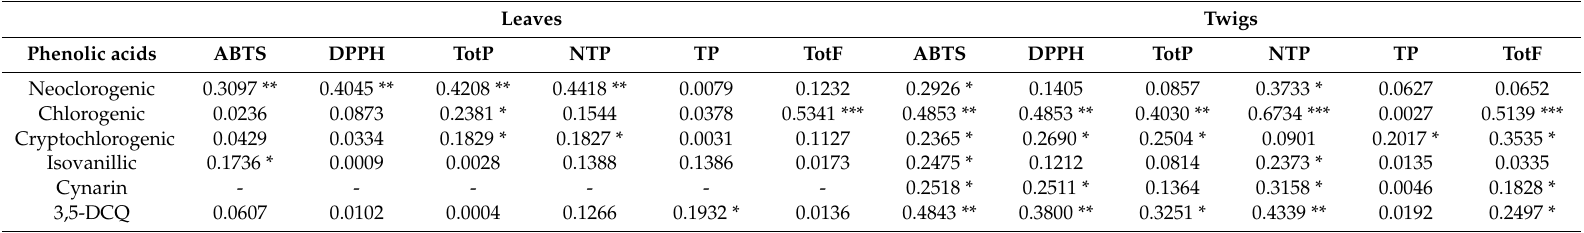
Table 6. Correlations (R 2 ) established between antioxidant capacity (ABTS, DPPH), total phenolics (TotP), non-tannic phenolics (NTP), tannic phenolics (TP), total flavonoids (TotF) and phenolic acids in leaves and twigs of the examined accessions of Parthenium argentatum harvested at 30 (winter) and 33 months (spring) after